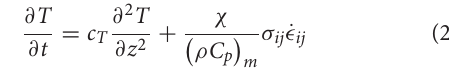
temperature difference) and fluxes (e.g., heat flow) in 1-D is the following